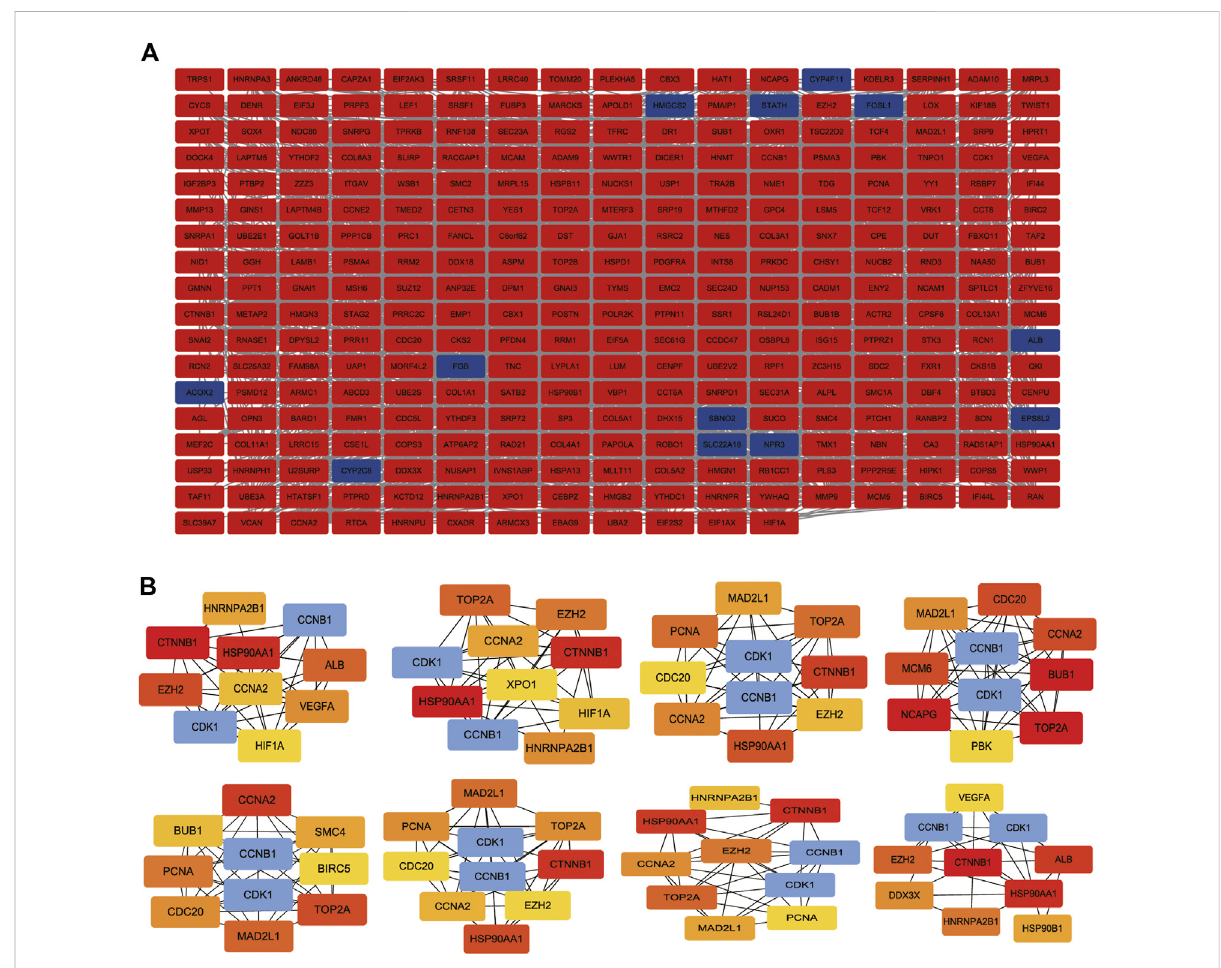
FIGURE 6 PPI network construction and analysis of hub genes. (A) The most signi fi cant module was obtained from the PPI network with 301 nodes and 2369 edges. (B) The hub genes were selected from the PPI network using the cytoHubba plugin. DEGs, differentially expressed genes; PPI, protein – protein